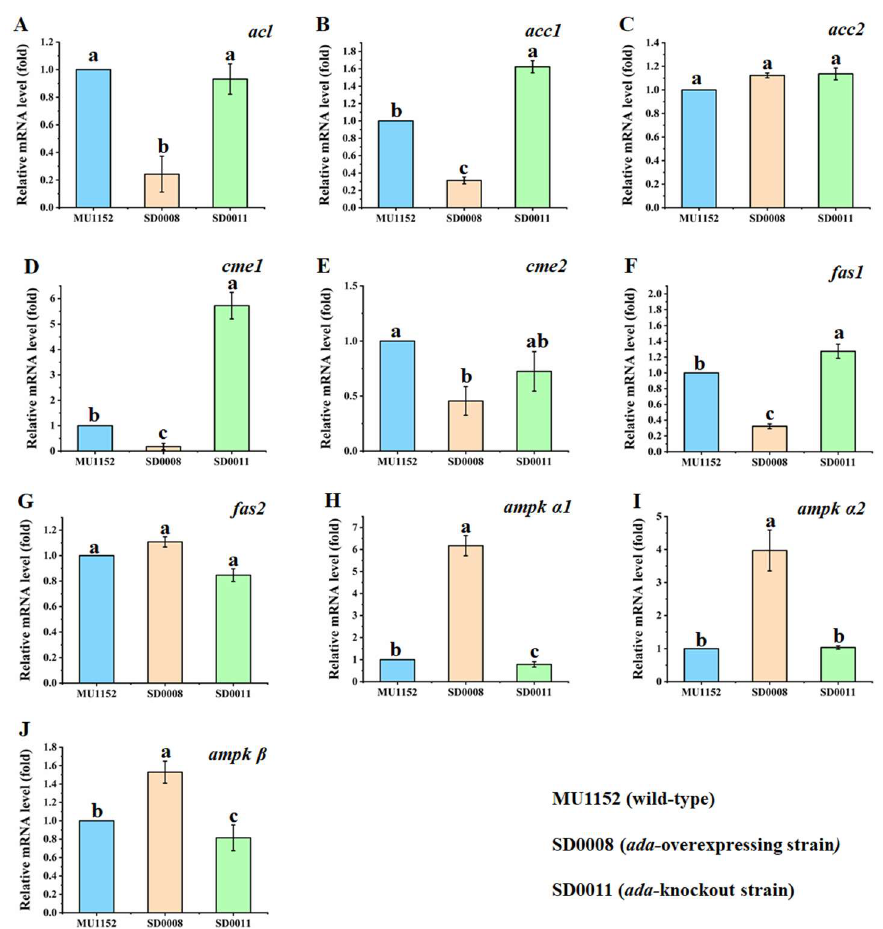
Figure 5. Expression profiles of key genes in ada -overexpressing and ada -knockout strains at 24 h. ( A ) acl , ATP-citrate lyase; ( B ) acc1 , ( C ) acc2 , acetyl-CoA carboxylase; ( D ) cme1 , ( E ) cme2, cytosolic malic acid enzyme; ( F ) fas1 , ( G ) fas2, fatty acid synthase; and ( H ) ampk α 1 , ( I ) ampk α 2, ( J ) ampk β , AMP-activated protein kinase. Data were collected from three biological replicates and showed significant differences ( p < 0.05) when they do not share common